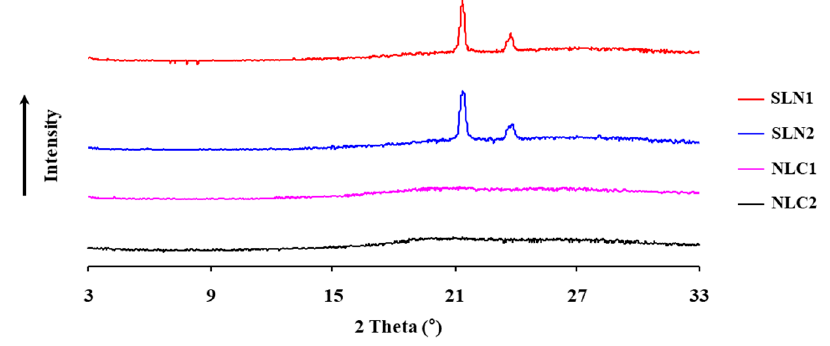
Figure 5. X-ray di ff raction patterns of SLN and NLC with and without fucoxanthin. Fucoxanthin Figure 5. X-ray diffraction patterns of SLN and NLC with and without fucoxanthin. Fucoxanthin was was loaded to form SLN2 and NLC2, respectively. SLN1 and NLC1 were formed without loaded to form SLN2 and NLC2, respectively. SLN1 and NLC1 were formed without fucoxanthin, fucoxanthin, respectively. respectively.